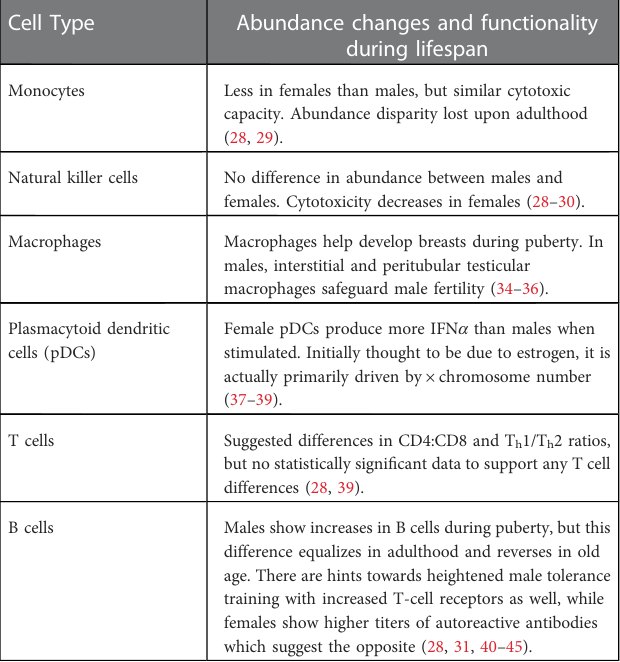
TABLE 1 An overview of immune system changes during